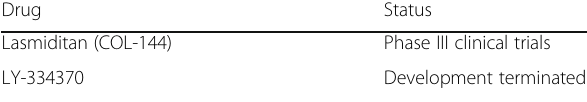
Table 1 Overview of ditans in alphabetical